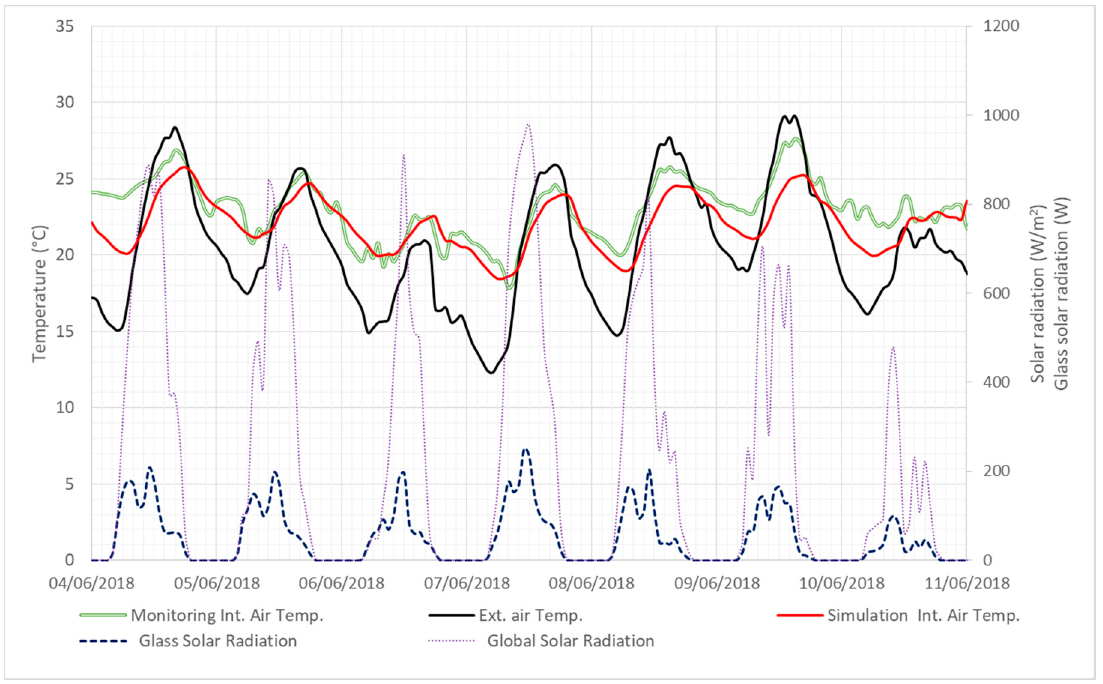
Figure 9. Indoor simulated and monitored temperature, exterior temperature and solar radiation, during 24 h natural cross ventilation scenario.